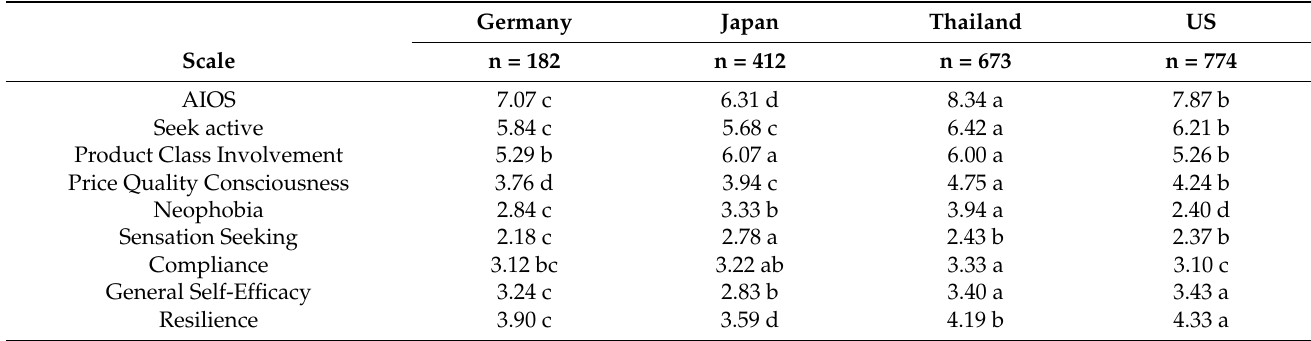
Table 4. Psychographics ratings by country.